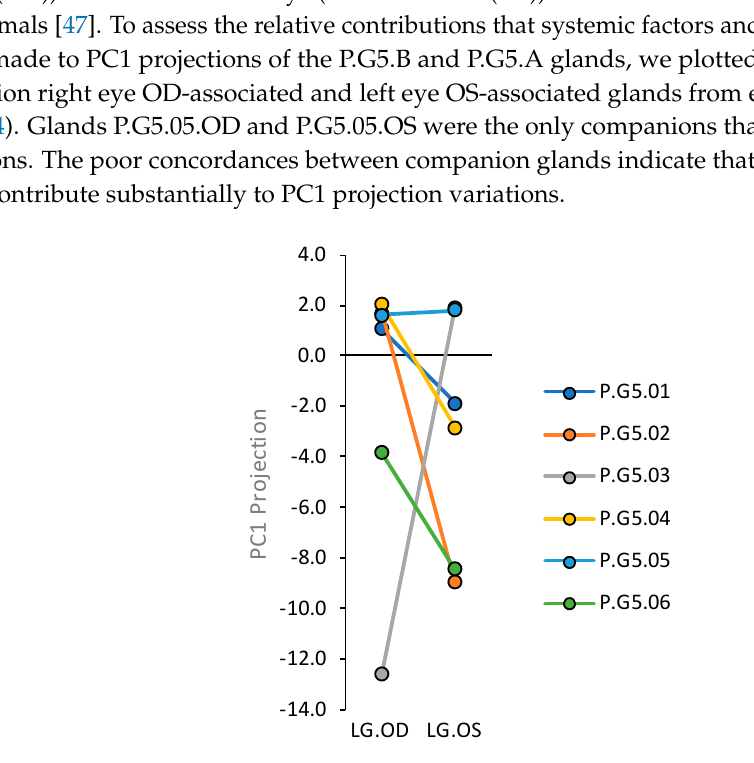
Figure 4. PC1 projections of right eye-associated (oculus dextrus (OD)) and left eye-associated (oculus sinister (OS)) glands from group P.G5. Table 1. Transcript Loadings to Significant Principal Components.